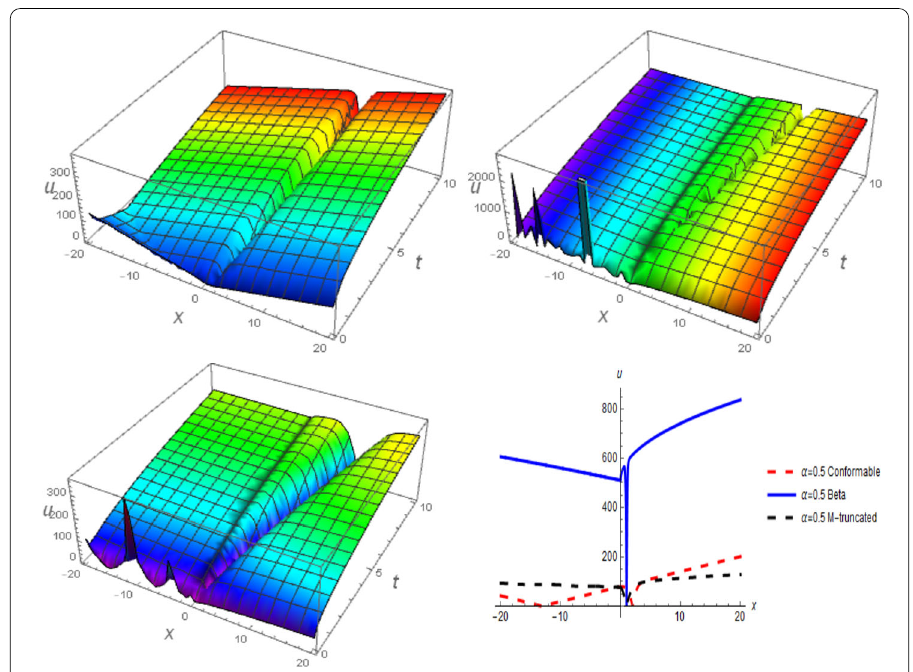
Figure 1 ( a ) 3D-plot of u 1 with conformable, ( b ) 3D-plot of u 1 for beta with α = 0.5. ( c ) 3D-plot of u 1 for M-truncated with α = 0.5, ( d ) 2D-plot of u 1 with t = 1